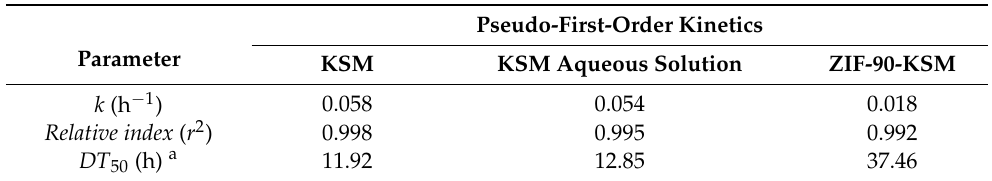
Table 1. Modeling parameters for photodegradation of KSM, KSM aqueous solution and ZIF-90-KSM under ultraviolet radiation.